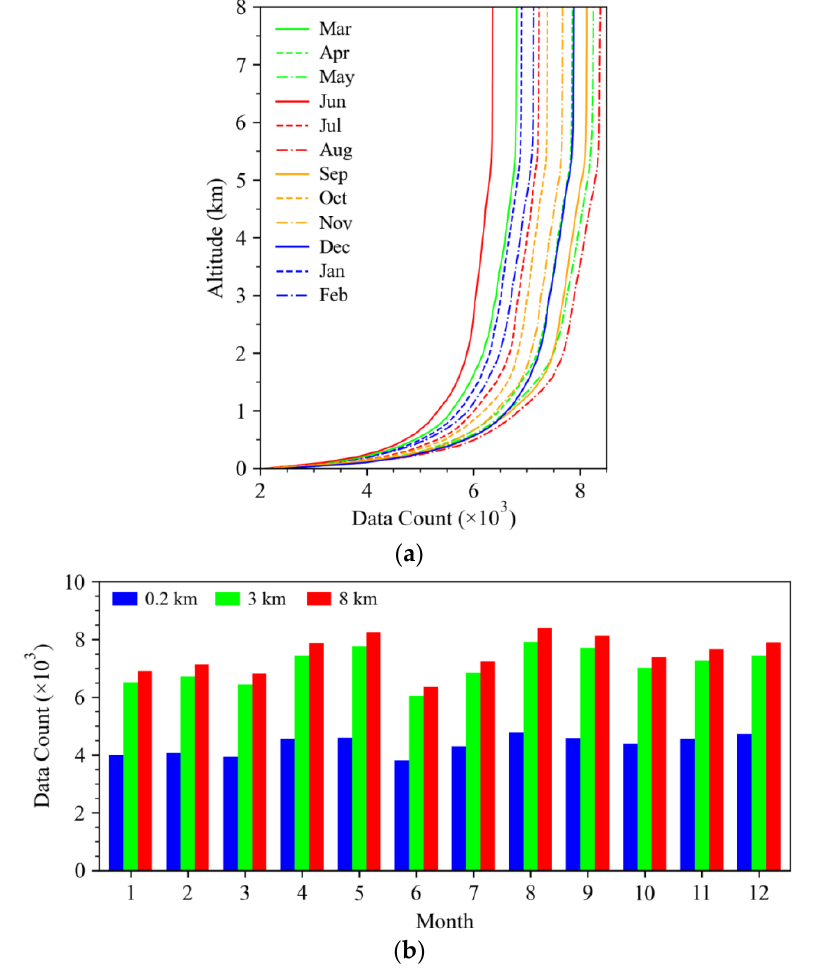
Figure 1. ( a ) Vertical distributions of the monthly COSMIC-2 RO data count in the SEP area in 2020, and ( b ) data counts at the 0.2 (blue), 3 (green) and 8 km (red) altitudes.